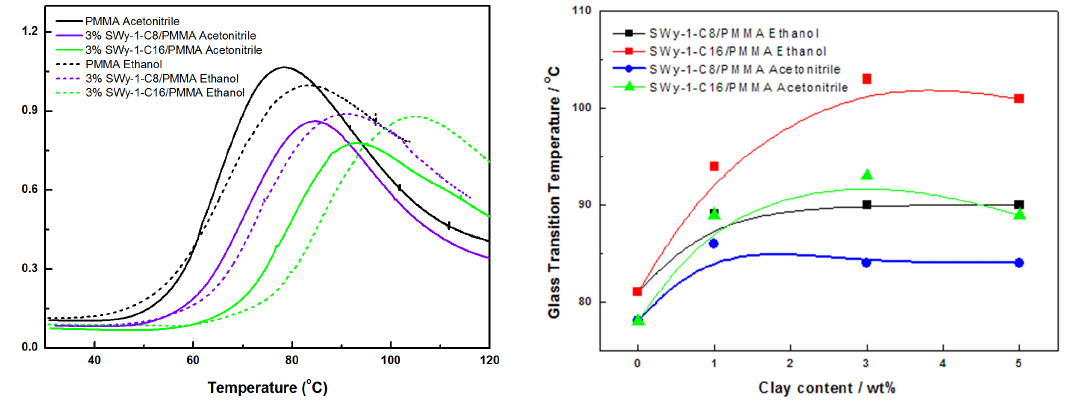
Table 1. Glass transition temperature and molecular weight (M